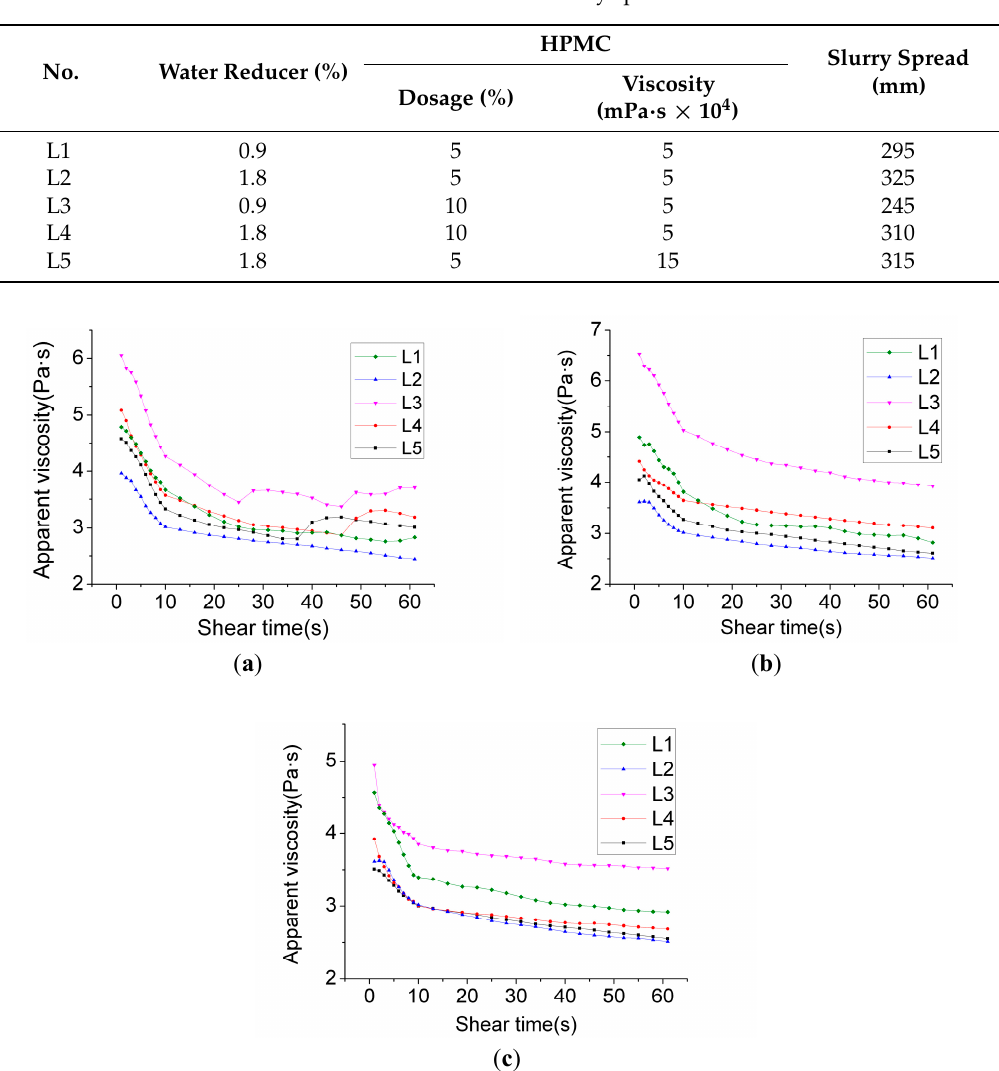
Figure 2. Relationship between the slurry shear rate and the apparent viscosity at a constant shear rate. ( a ) Constant shearing velocity test (hydration for 0 min); ( b ) Constant shearing velocity test (hydration for 30 min); ( c ) Constant shearing velocity test (hydration for 120 min).